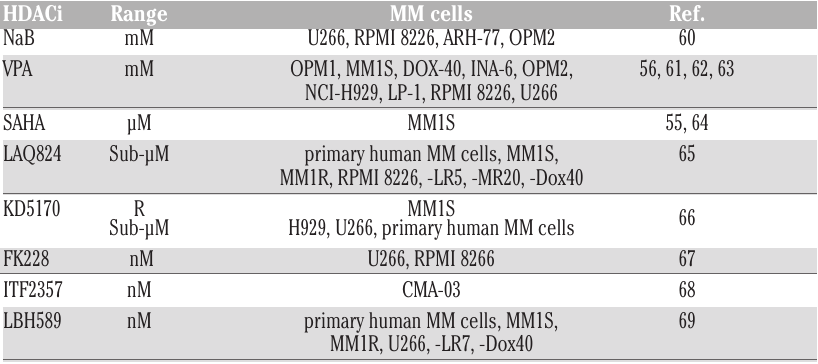
Table 2. Potency of HDACi used in different in vitro MM